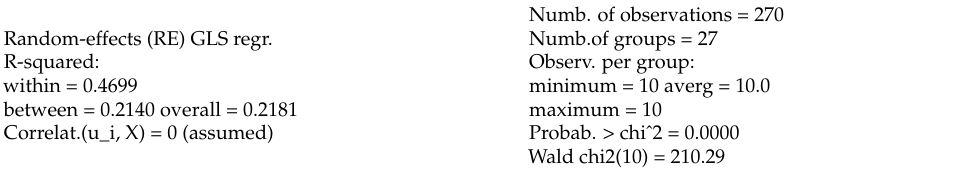
Table 2. The random-effects generalized least-squares (GLS) regression of the renewable electricity consumption per capita (%) for the panel of 27 EU members in 2011–2020. Random-effects (RE) GLS regr. R-squared: within = 0.4699 between = 0.2140 overall = 0.2181 Correlat.(u_i, X) = 0 (assumed)